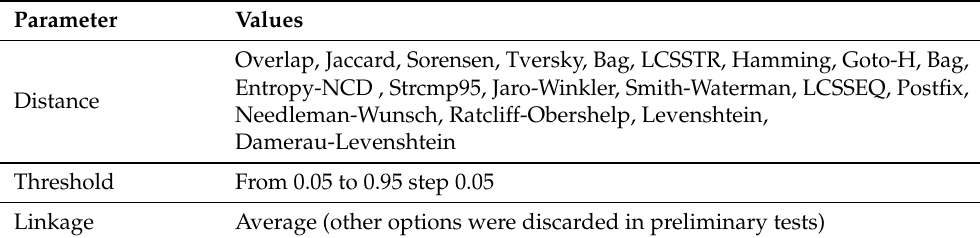
Table 3. Experiment parameters for Agglomerative